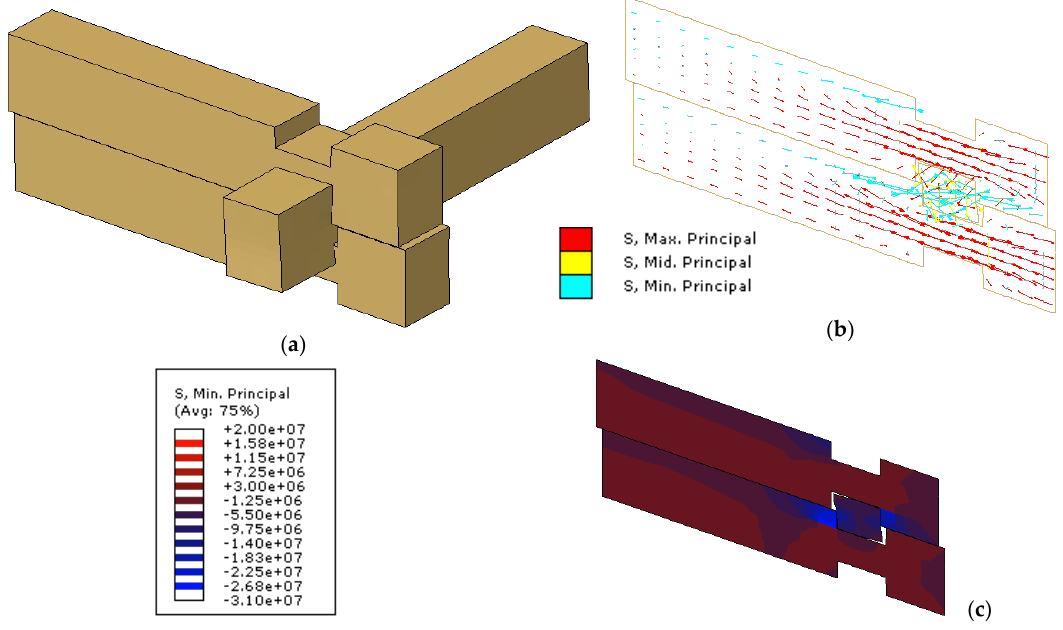
Figure 6. Standard joint under in-plane lateral loads (push-out, P = 10 kN), at an imposed displacement δ = 15 mm (ABAQUS, FE-STRU). ( a ) Deformed shape, with ( b ) distribution of principal stresses (vectorial representation) and ( c ) contour plot of compressive stresses (legend in Pa).